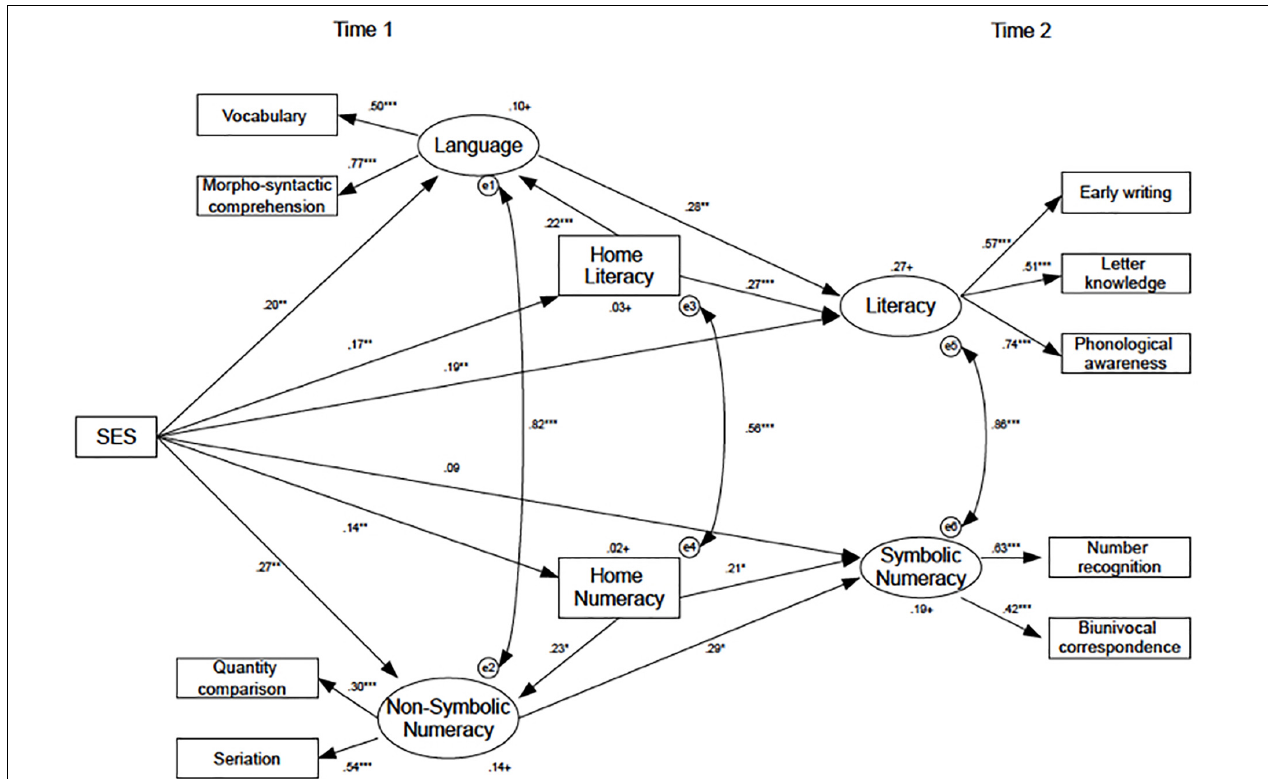
FIGURE 1 | Model 1 on the relationships between SES and children’s early language/literacy and symbolic/non-symbolic numeracy skills with Home Literacy and Home Numeracy as